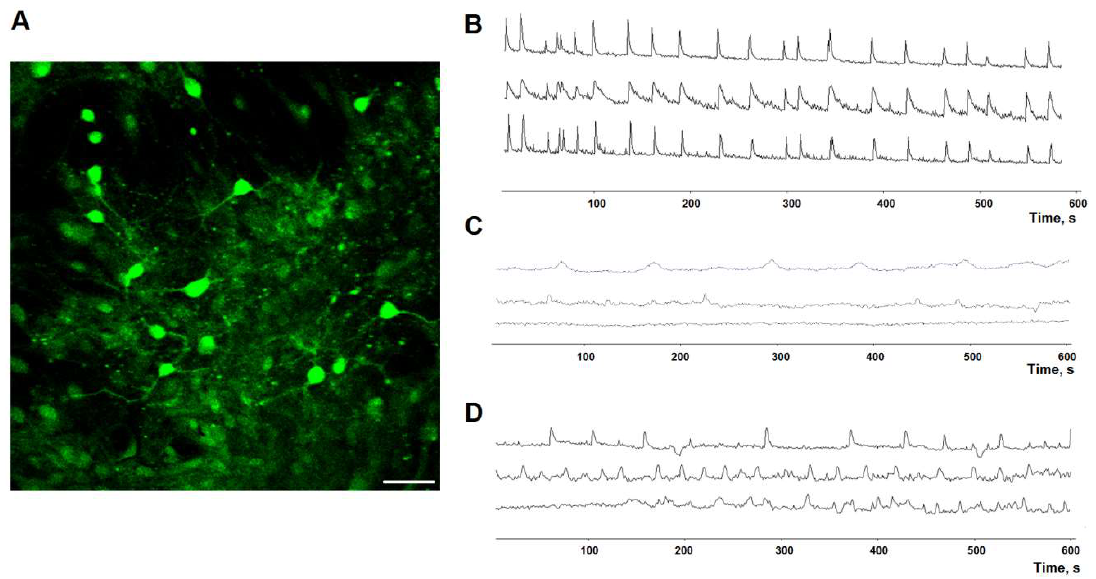
Figure 9. Ca 2+ activity in primary hippocampal cultures on day 7 of the posthypoxic period. ( A ) Example fluorescence image of the calcium-sensitive dye Oregon green 488 BAPTA in culture. Scale bar 20 μm. ( B – D ) Representative Ca 2+ recordings, ( B ) sham; ( C ) hypoxia; ( D ) hypoxia + AAV-BDNF-EGFP.